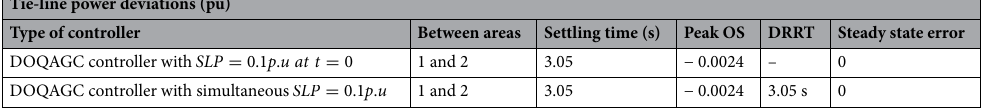
Table 10. Performance of COQAGC in terms of POS, ST and DRRT with simultaneous disturbances.